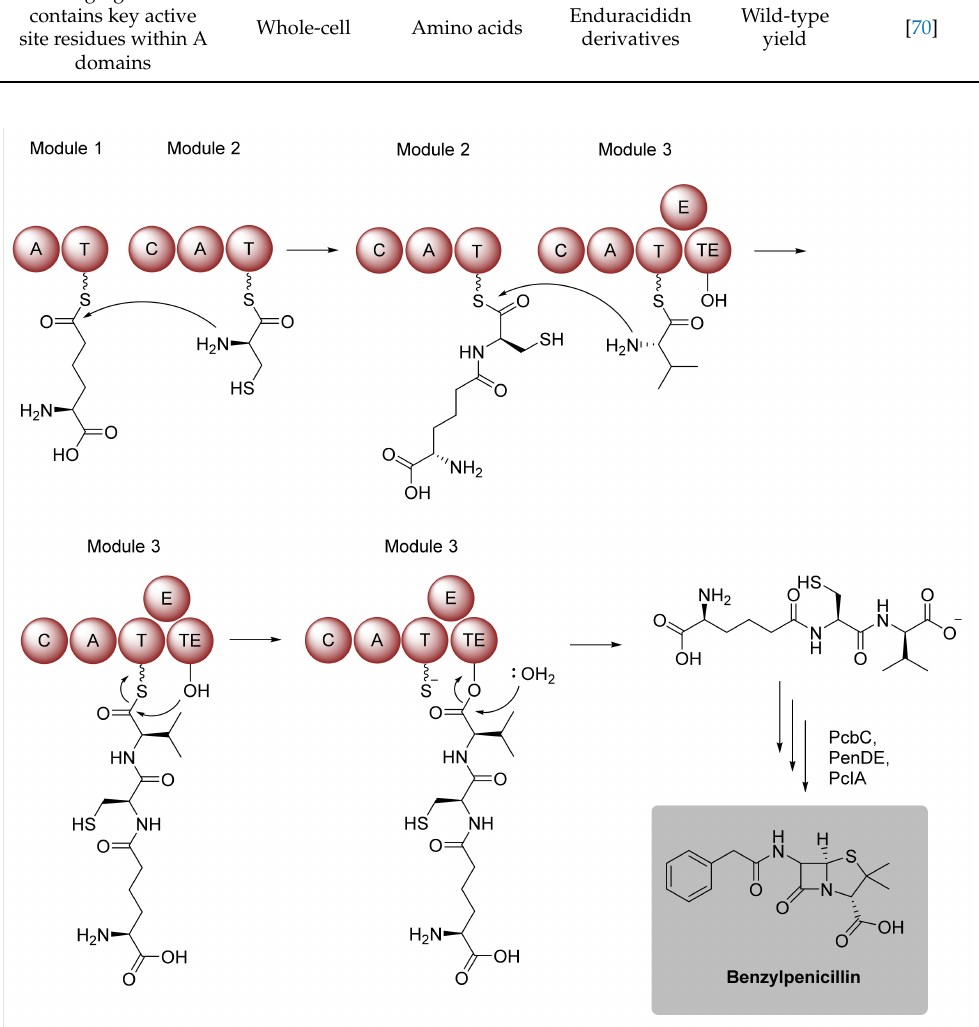
Figure 9. Penicillin biosynthesis in Penicillium chrysogenum as textbook example of NRPS assembly logic. Domain notation: A, adenylation; T, thiolation; C, condensation; E, epimerase; TE,